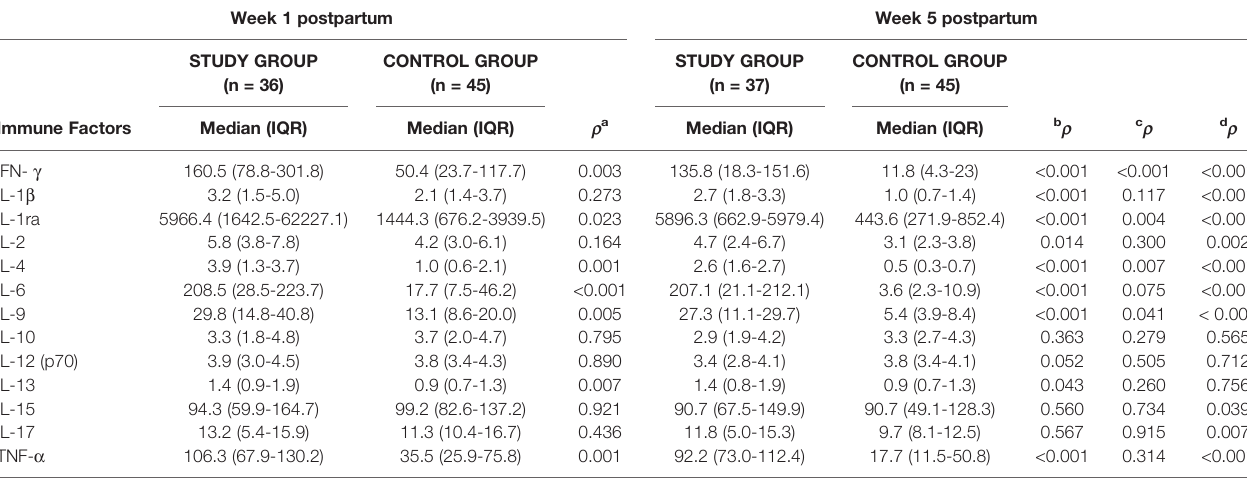
TABLE 1 | Concentration (ng/l) of cytokines in milk samples of study and control group women over